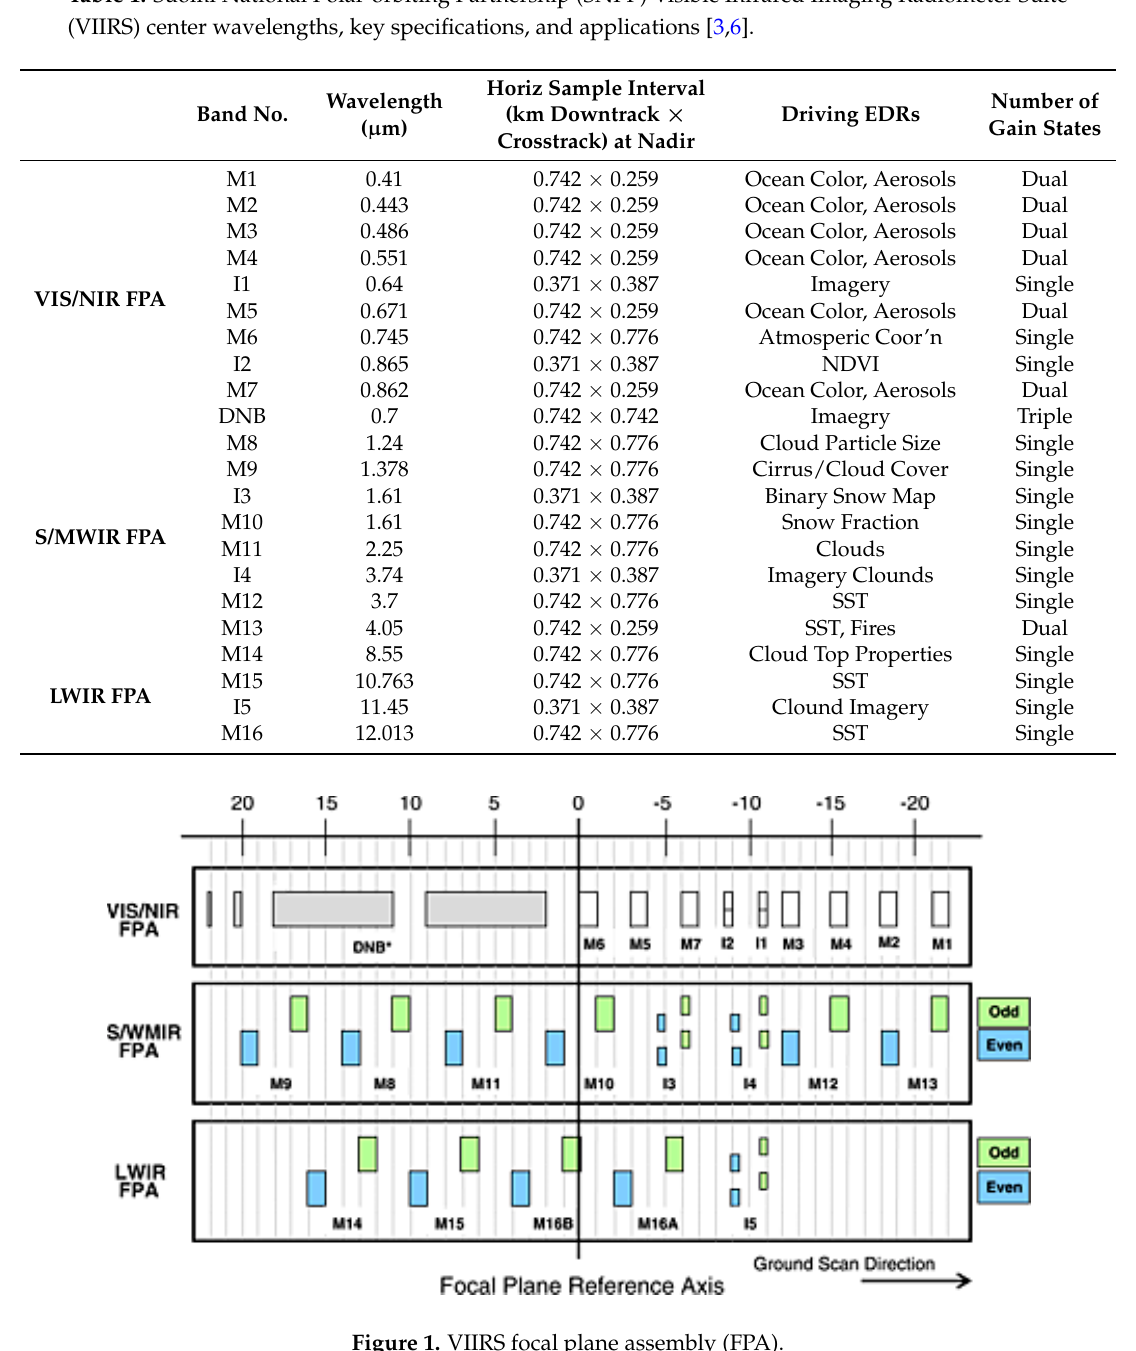
Figure 1. VIIRS focal plane assembly (FPA).